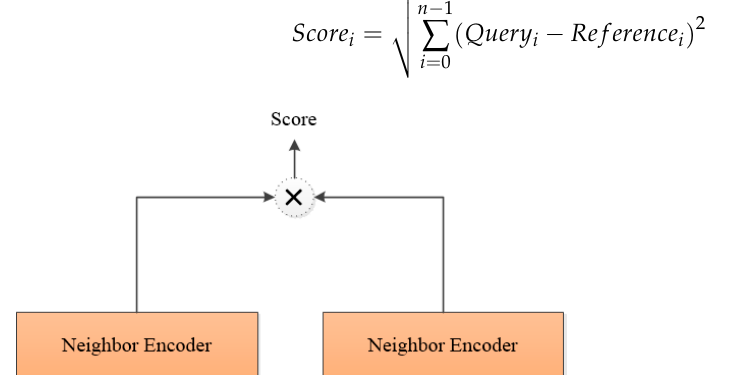
Figure 6. The schematic diagram of the matching processor process. LSTM is used to obtain the similarity score of candidate entities as follows: )( ' fewfew SEncoderEnhancedS −=